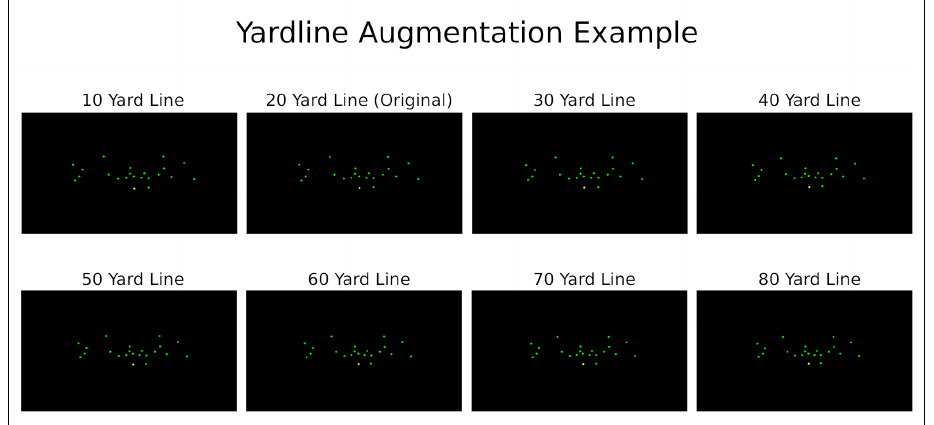
Figure 8. yard line augmentation example—the original data for these augmentations came from a formation on the 20-yard line. Formations on the 10-, 30-, 40-, 50-, 60-, 70-, and 80-yard lines are artificially augmented with the 2D affine